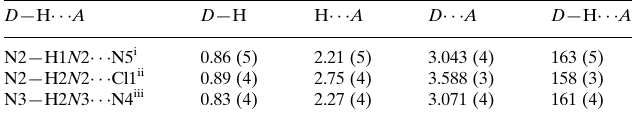
Hydrogen-bond geometry (A˚ , (cid:2)